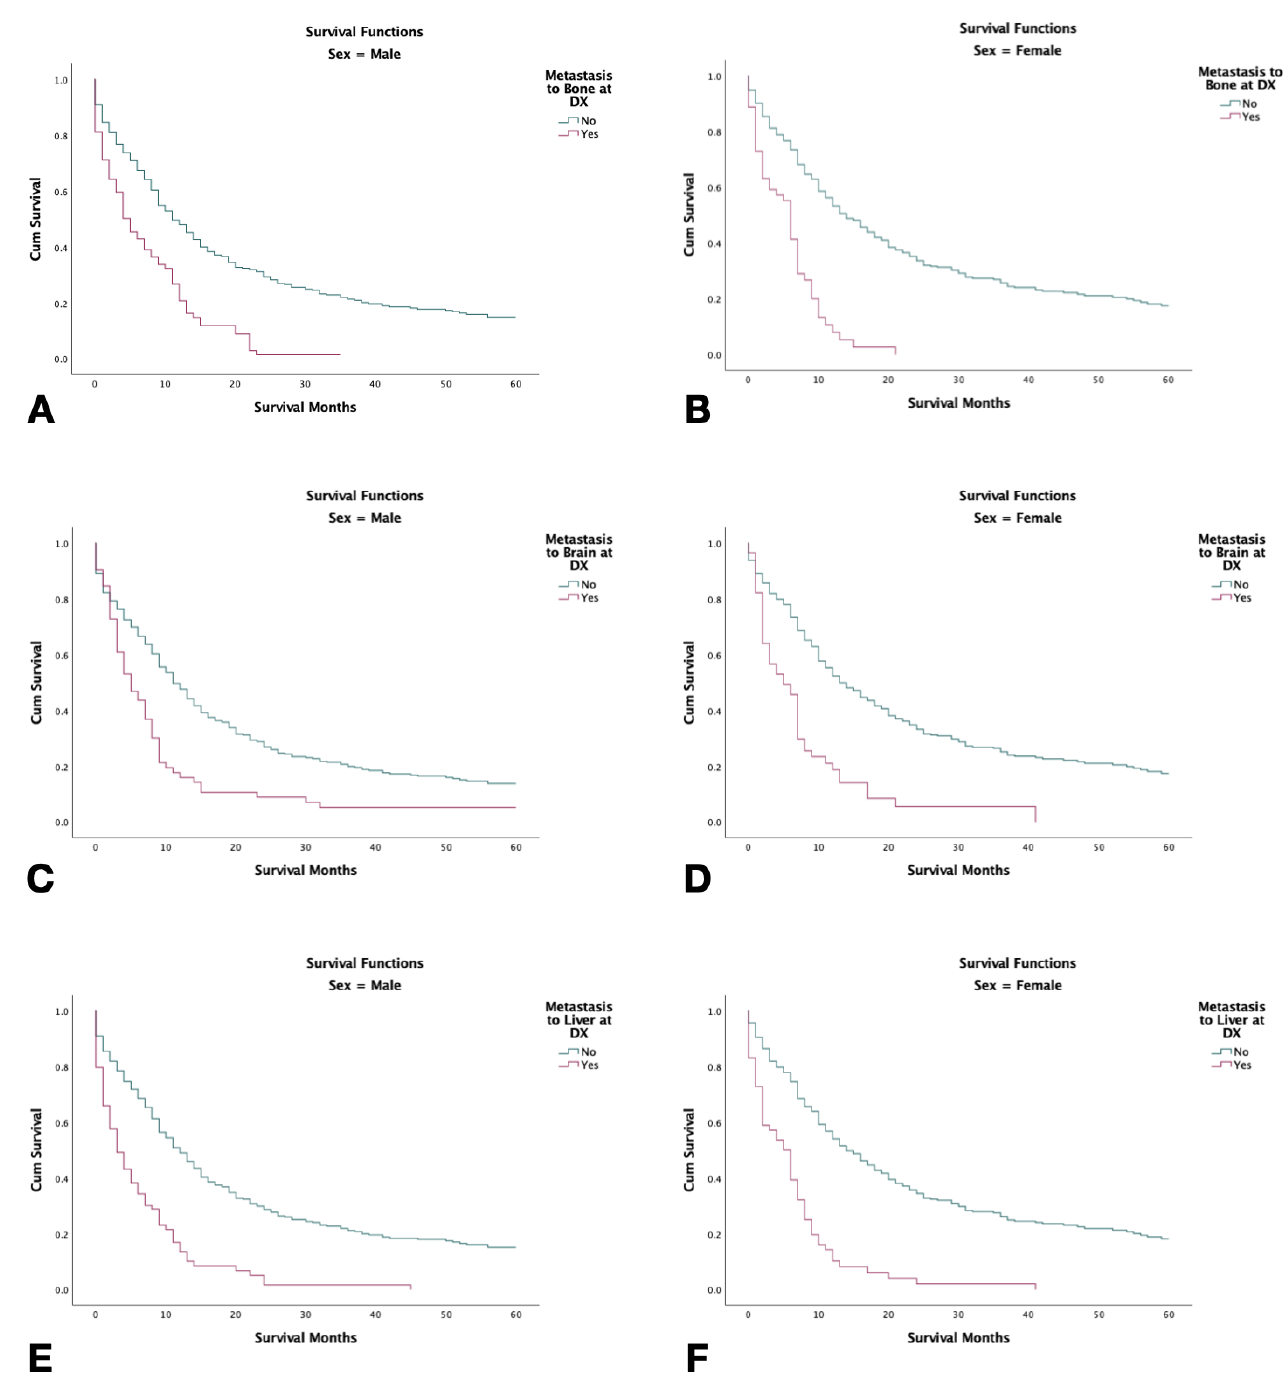
Figure 4. Kaplan – Meier survival graphs of 2126 combined small-cell lung cancer patients with me- tastasis at the time of diagnosis stratified by sex with (2000 – 2018). ( A , B ) Survival in males and fe- males with metastasis to bone. ( C , D ) Survival in males and females with metastasis to the brain. ( E , F ): Survival in males and females, respectively, with metastasis to the liver. Log rank (Mantel–Cox) analysis ( χ 2 ) performed on each independent variable ( p < 0.001).